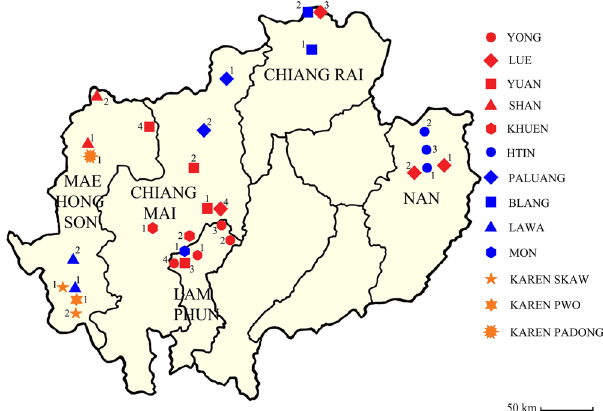
Figure 3. Geographical map representation of sampling areas and distribution of the ethnic groups residing in northern Thailand. The red colour represents Tai-Kadai speaking ethnic groups, the blue colour represents the Austro-Asiatic speaking ethnic groups and orange indicates the Sino-Tibetan speaking ethnic groups. This figure was modified using the Photoshop program. The original source of this figure can be found at https://commons.wikimedia.org/wiki/File:Thailand_location_map.svg which is licensed under the “Creative Commons Attribution 3.0 Unported” that is free to share (to copy, distribute and transmit the work) and remix (to adapt the